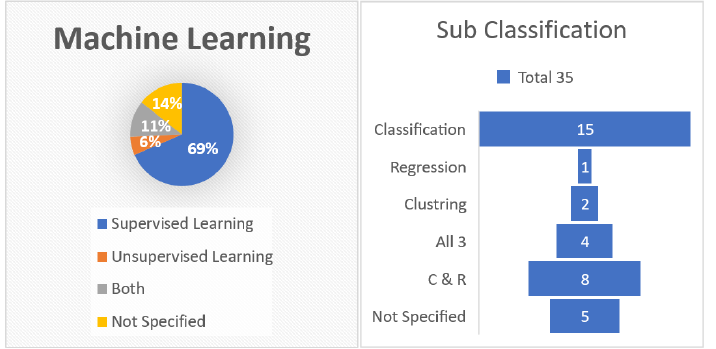
Figure A1. Literature analysis.